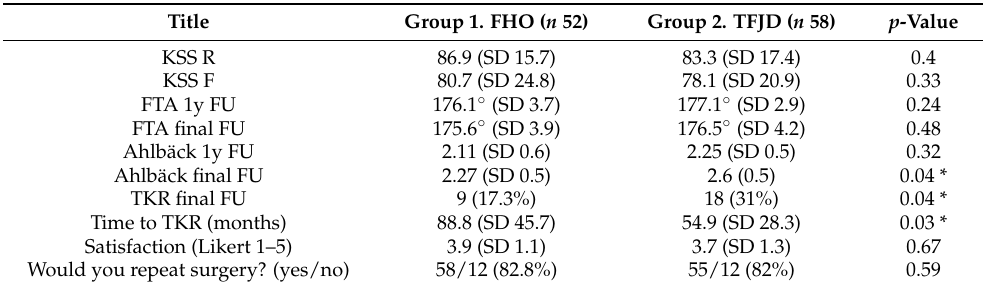
Table 5. Results summary relative to the FHO or TFJD group in non-overcorrected patients, FTA ≤ 180 ◦ : clinical results (KSS R and KSS R), radiological 1 year follow-up (FTA 1y FU and